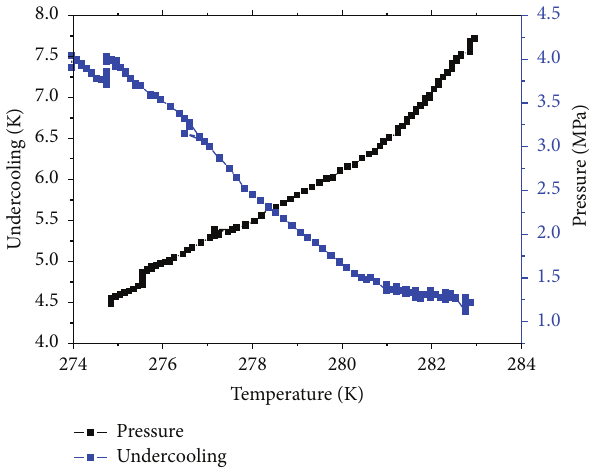
Figure 5: Pressure and undercooling versus temperature of hydrate